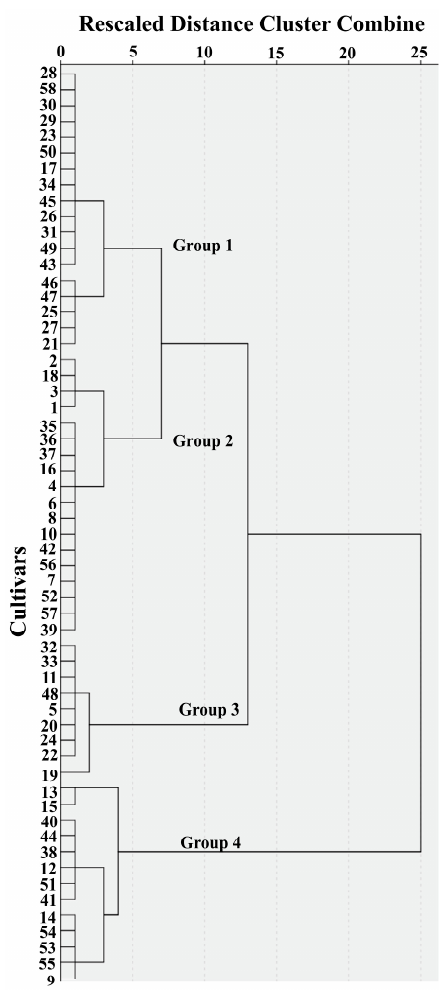
Figure 2. Hierarchical cluster analysis dendrogram (Ward’s method) based on individual LPL content of 58 wheat cultivars.